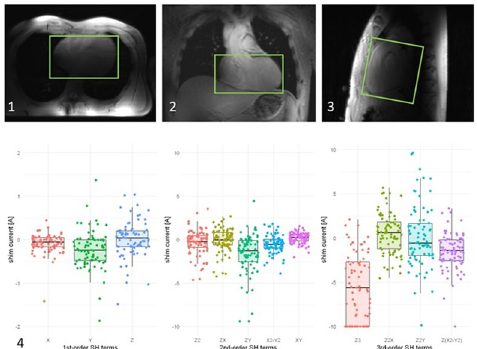
Fig 1. Upper row: The survey scan shows an exemplary shim volume in a transversal (A), coronal (B) and sagittal (C) view. Lower row: Overview over all extracted shim currents for the 1 st - to 3 rd -order spherical harmonics (SH) terms. Each color represents the current required to generate a specific SH term. For each current, the minimum and maximum, first and third quartile and the median value are shown. Note that the current required to generate the Z3 component reached the hardware limitation of ± 10A for a number of